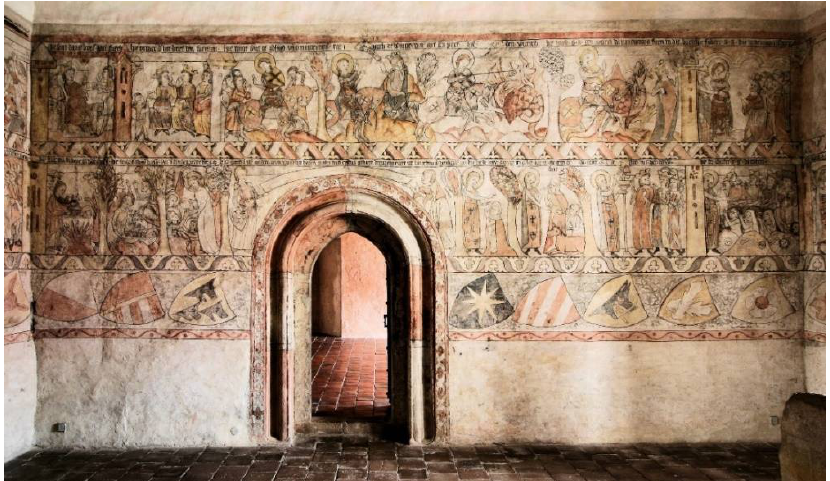
Figure 22. Jindřichův Hradec, castle. St. George’s cycle in the palace. Paintings dated to 1338. Photo by František Záruba, the author’s own work.